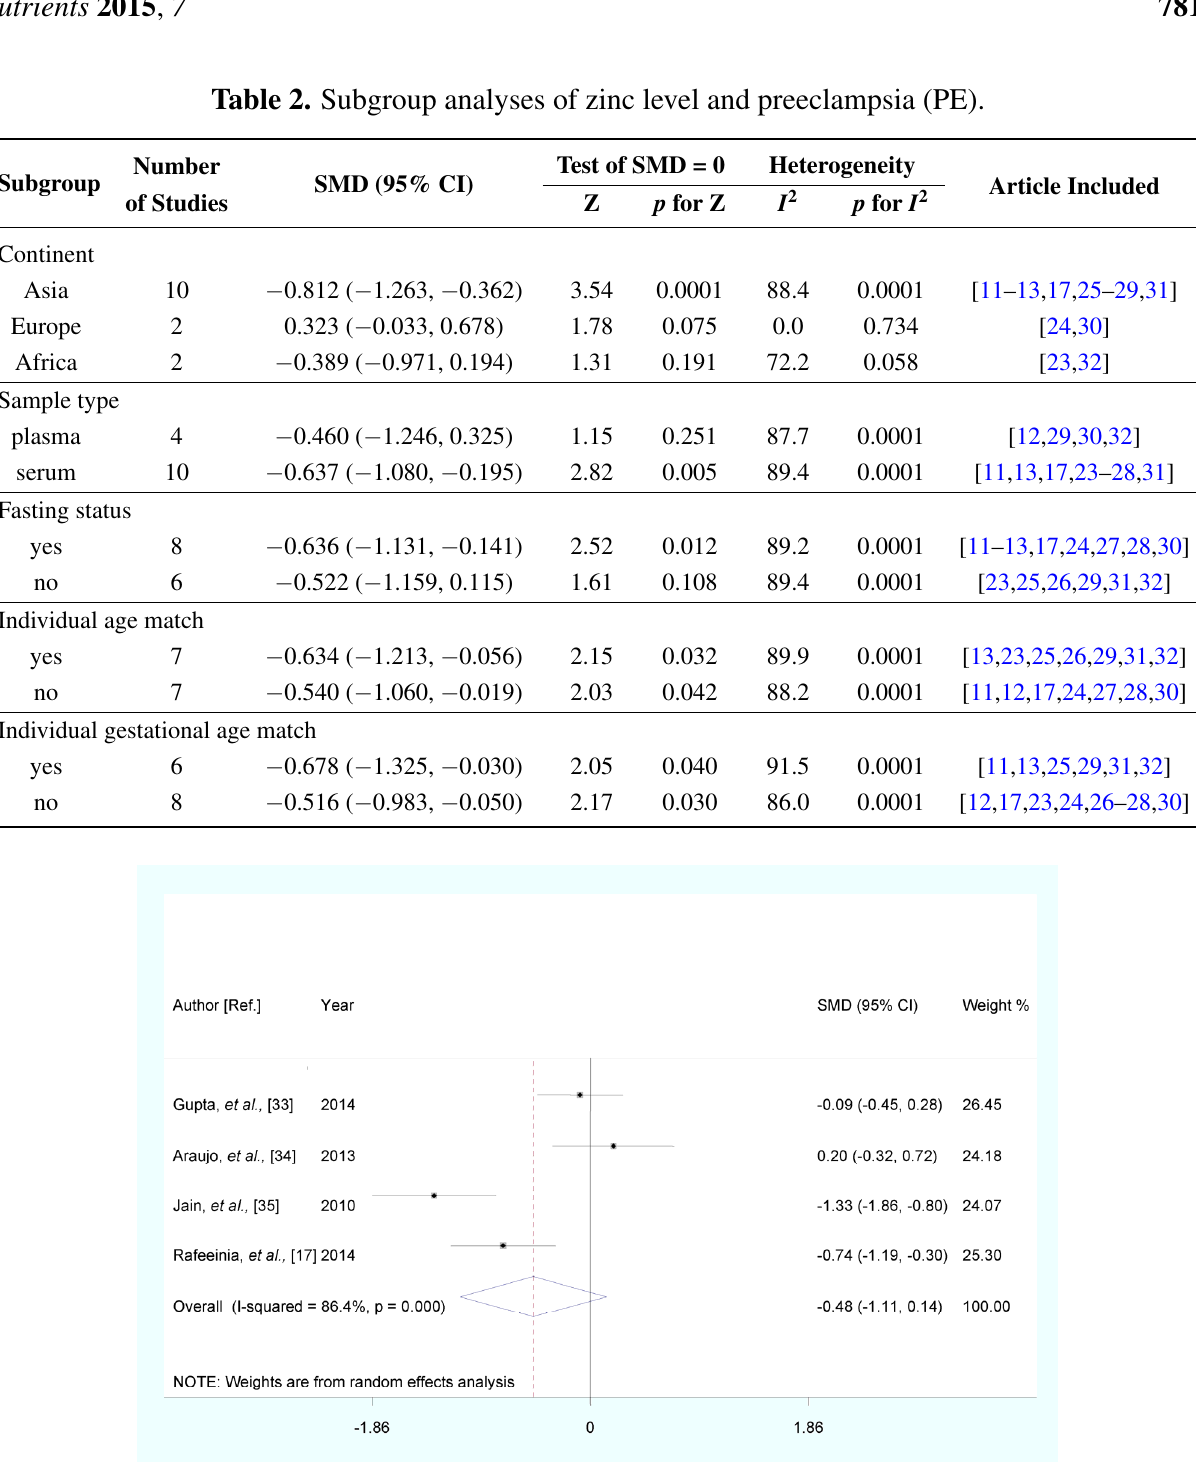
Figure 3. Forest plot of standard mean difference (SMD) with corresponding 95% CI of studies on zinc levels in mild PE and healthy pregnancy controls. The size of greybox is positively proportional to the weight assigned to each study, and horizontal lines represent the 95% CIs.